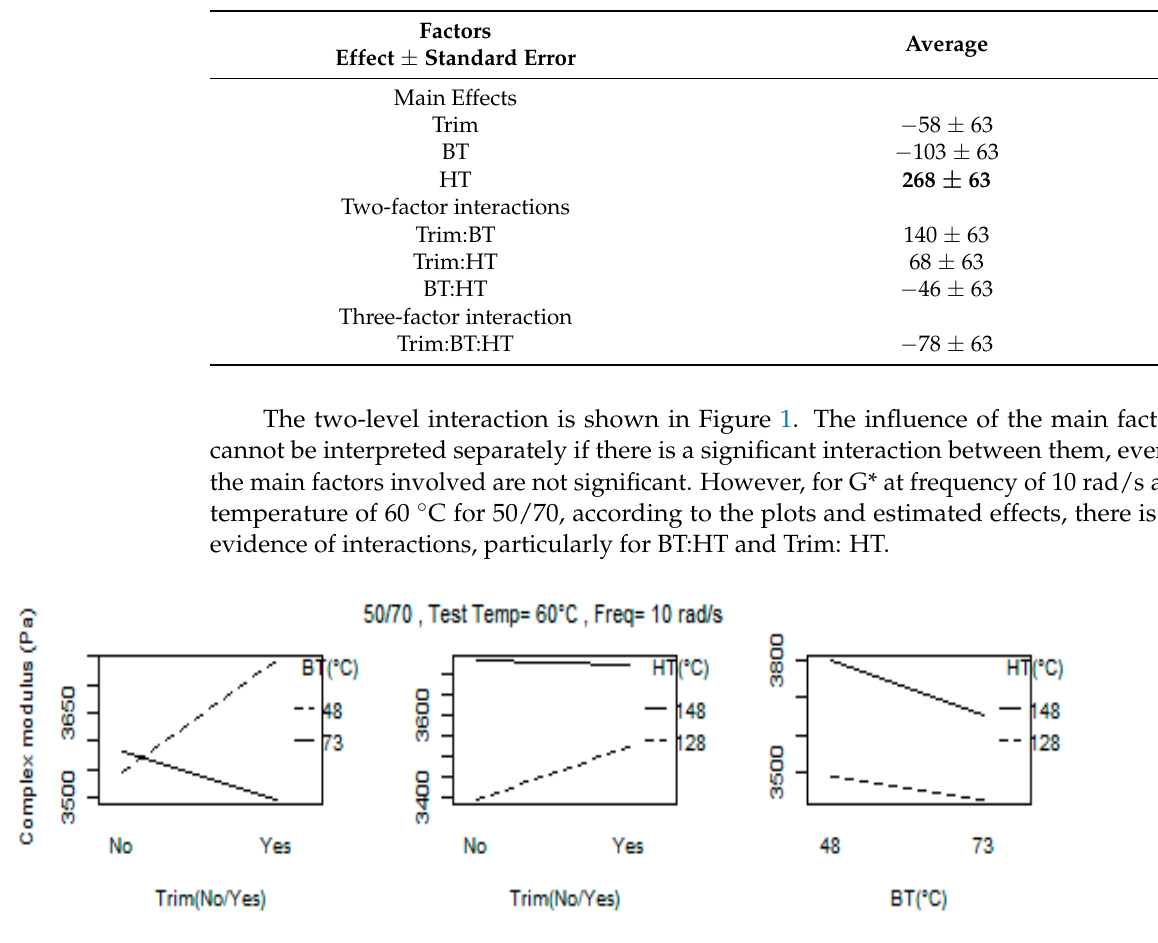
Table 4. Average Effect with Standard Error for the G* ( ω = 10 rad/s) at 60 °C for 50/70.